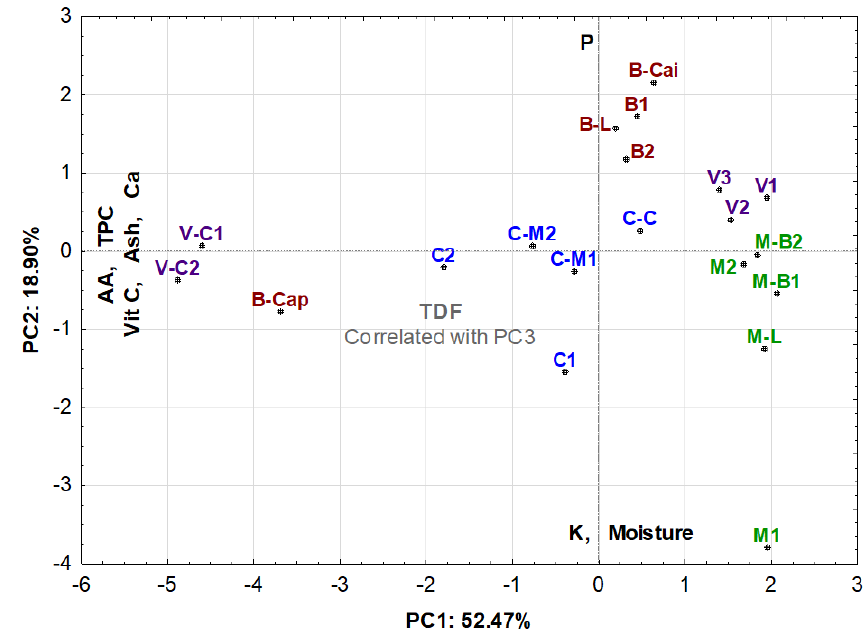
Figure 1. Principal component analysis projection of the